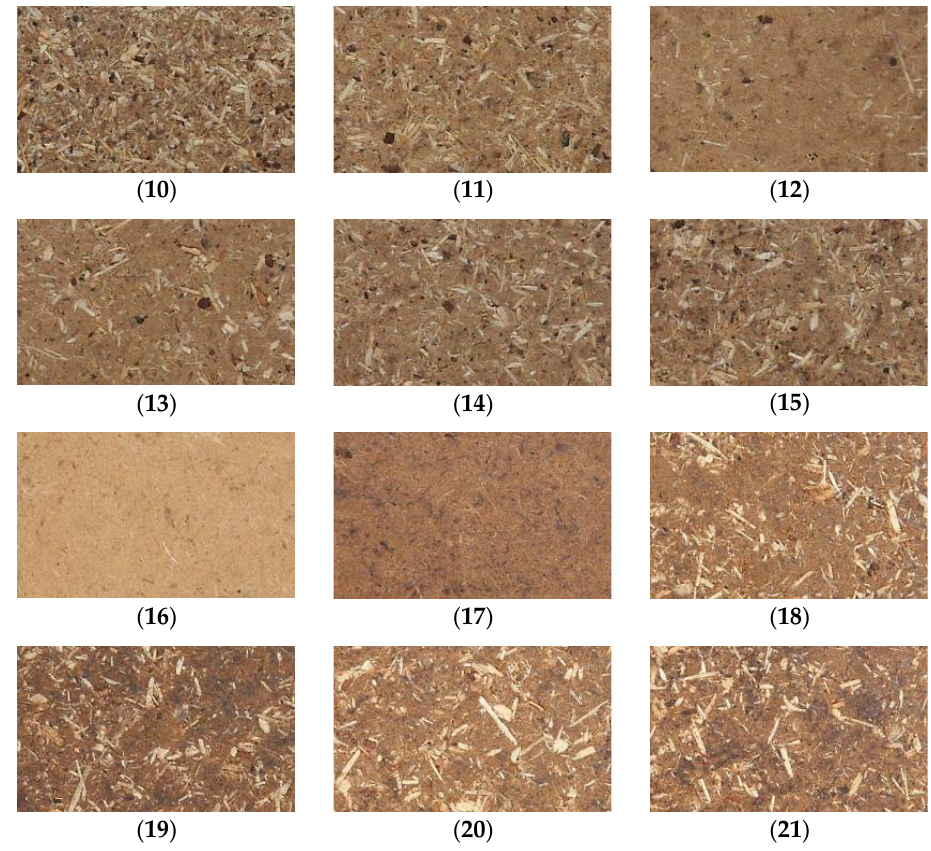
Figure 2. The pictures of the morphology of tested composite surface (the numbers in brackets refer to panel type — see Table 1; pictures dimensions: 30 mm (vertical) × 50 mm (horizontal)).